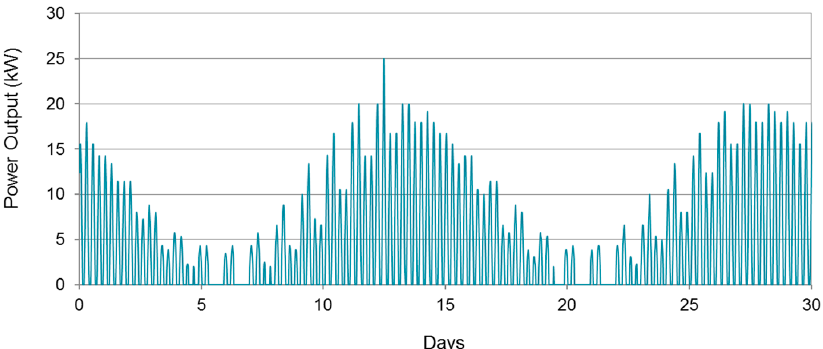
Figure 11. Estimated power generation for a 25 kW-rated tidal plant in [55].